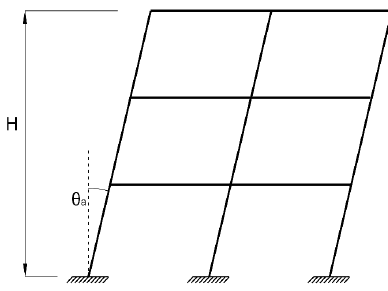
Figure 2 – Initial out of plumbness. Source: Adapted from NBR 6118-2014